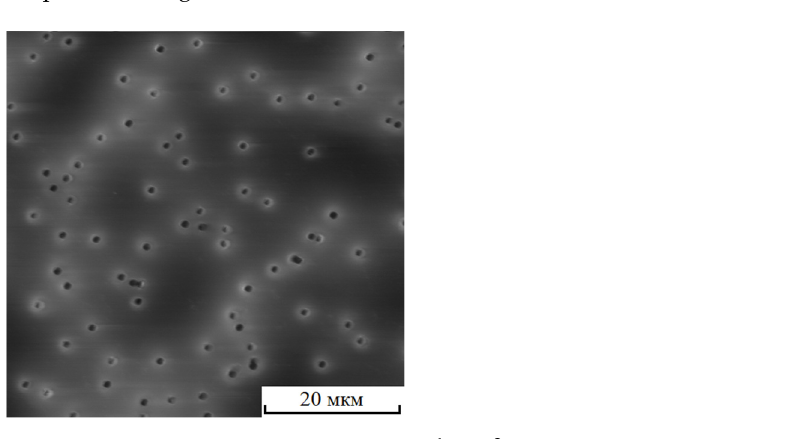
Figure 8. SEM image of TM with n = 4 × 10 6 cm − 2 and d = 1.16 μ m. The frame width is 52 μ m.